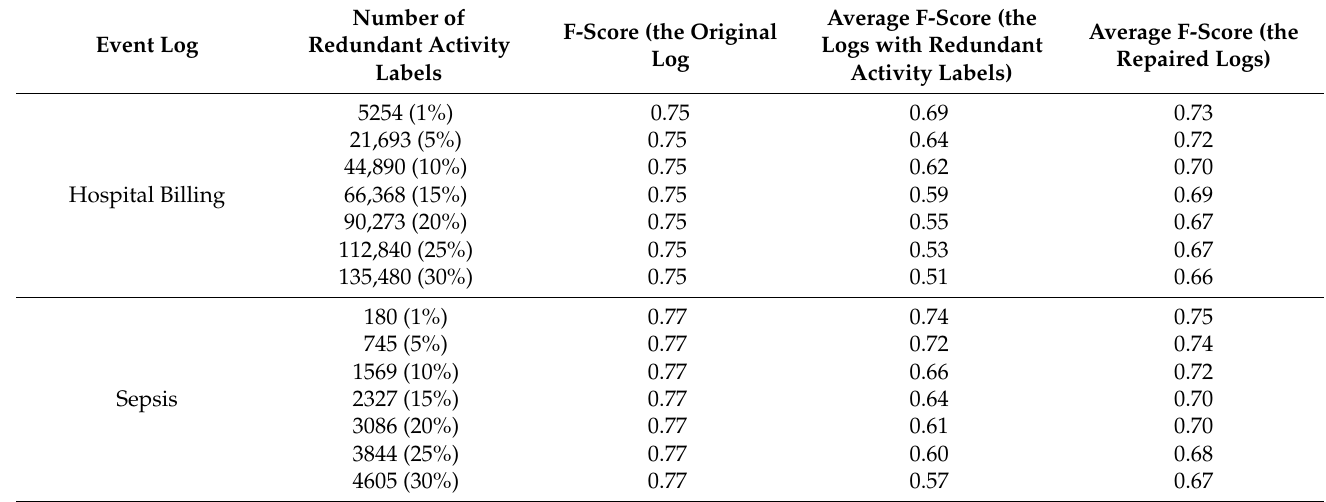
Table 4. F-score comparisons between process models discovered from the original, problematic, and repaired event logs.